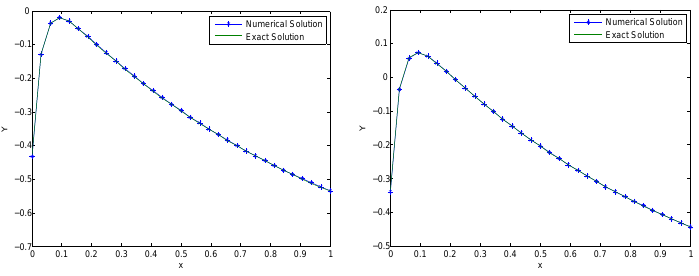
Figure 1. The behavior of the numerical solution at ε = 2 − 4 and N = 32 of Example 1 and Example 2 respectively. We can also observe from Figure 2 that, the point wise error are decreased as the number of mesh points